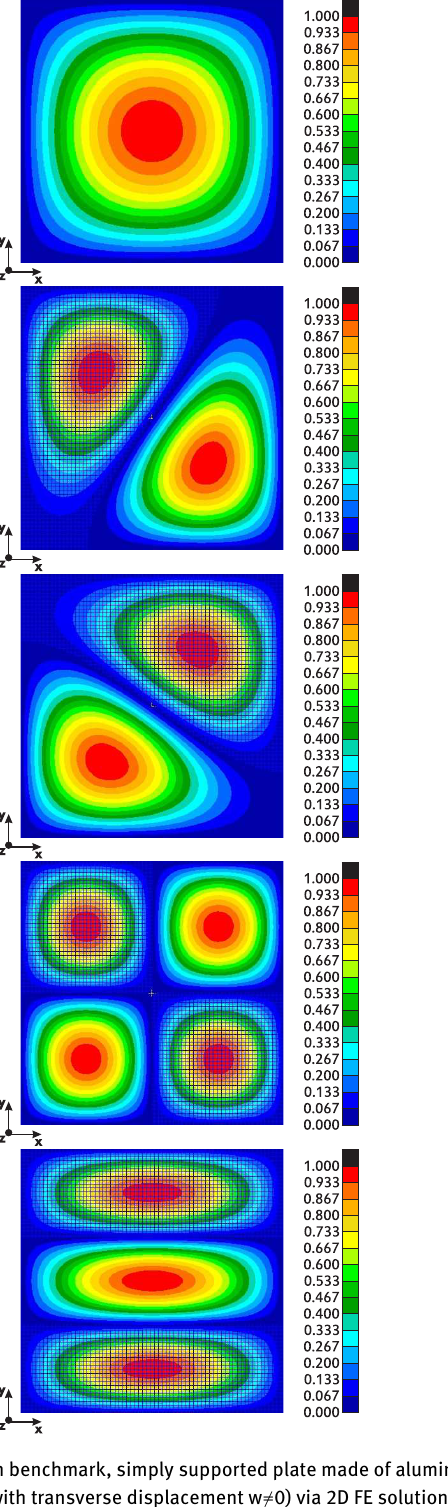
ployed in the MSC Nastran code is not able to investigate thick and moderately thin sandwich structures with a